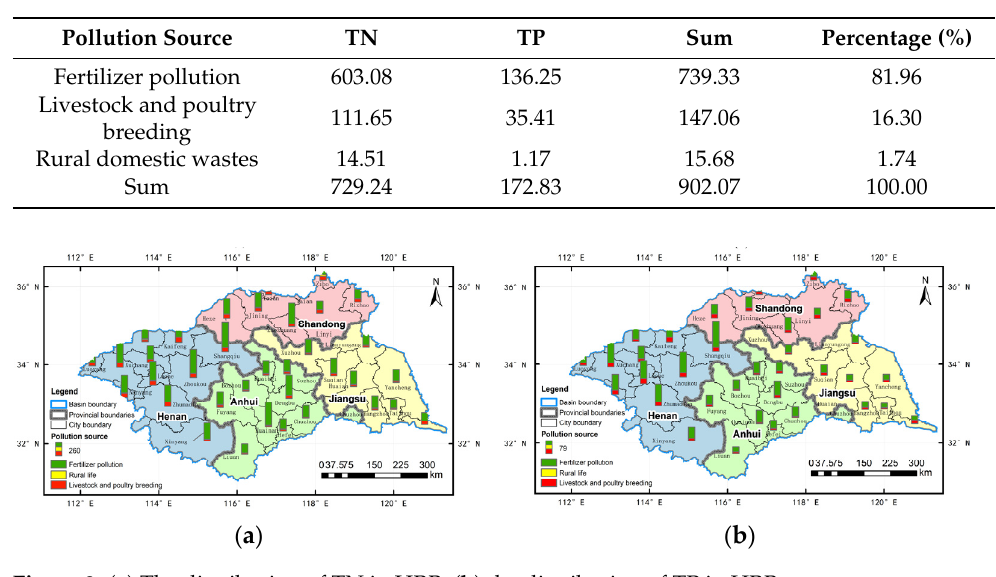
Table 2. Equal standard pollution load statistics (unit: 10,000 tons).